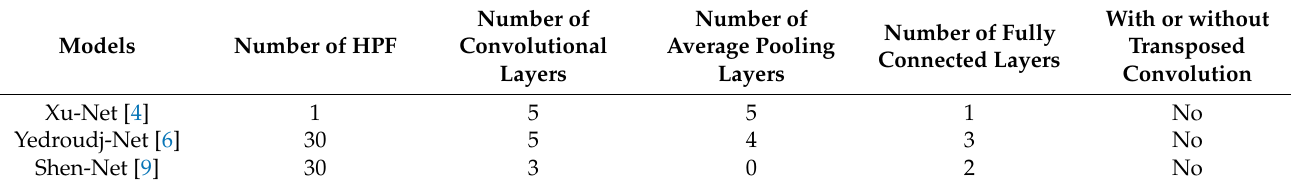
Table 1. Parameters of Xu-Net, Yedroudj-Net, and Shen-Net models.